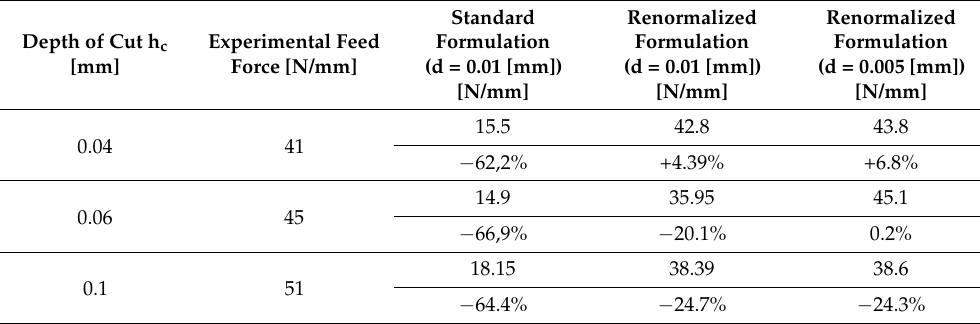
Table 5. Comparison between predicted and experimental feed forces F f for all